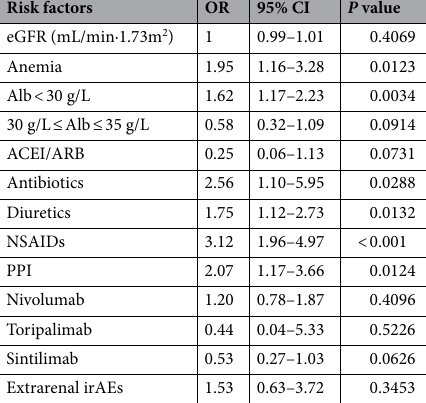
Table 2. Multivariate analysis of risk factors for AKI in patients receiving